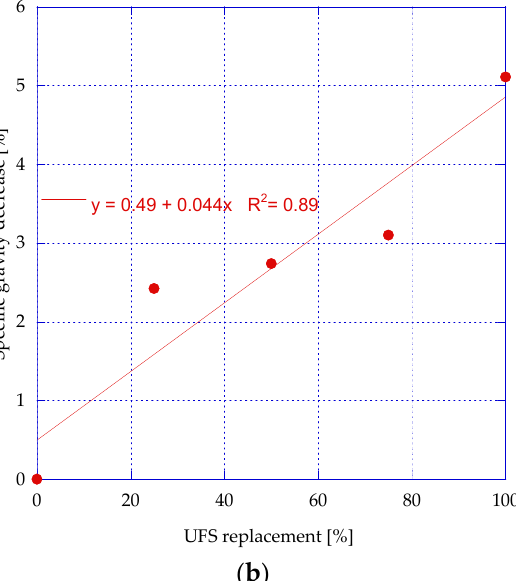
Figure 9. Specific gravity (g/cm 3 ) of the mortar mixes ( a ) and decrease in the specific gravity (%) ( b ).